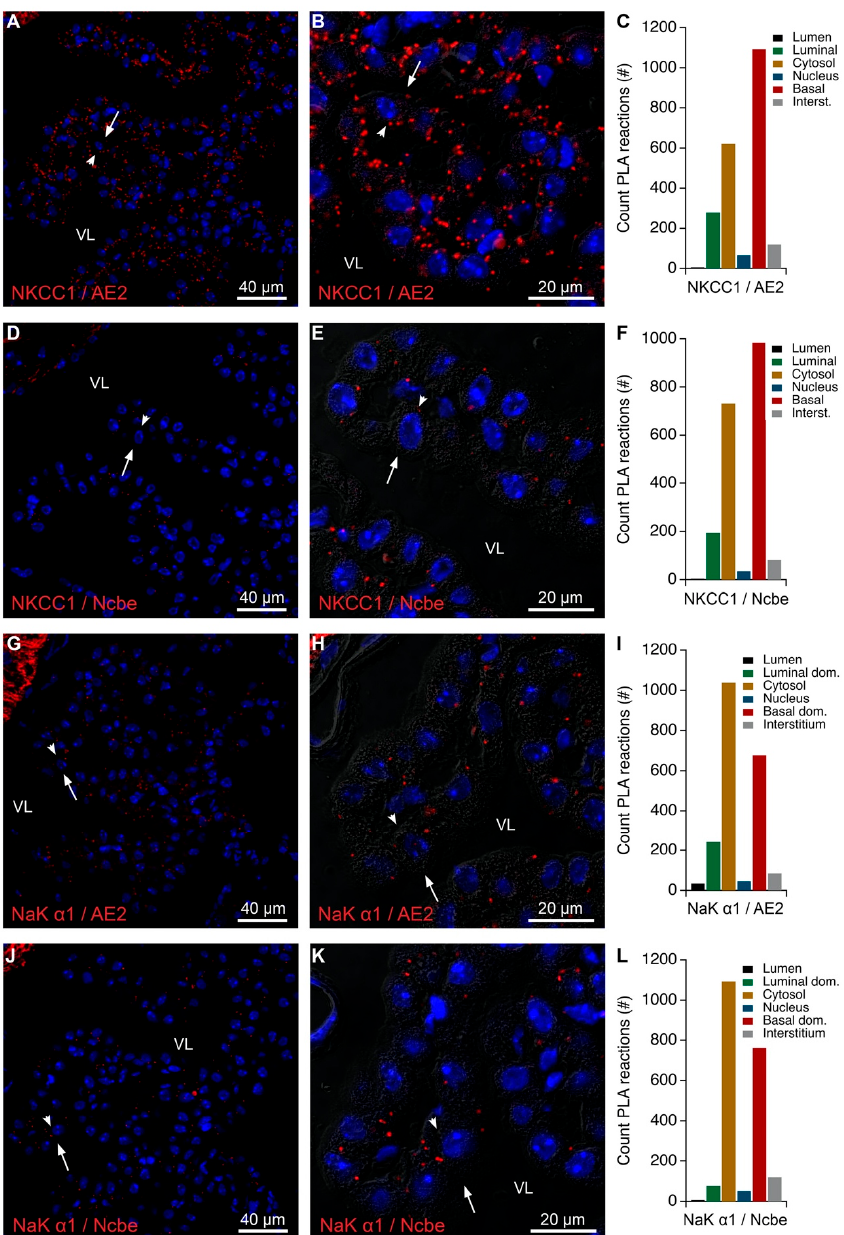
Figure 7. Colocalization of AE2 or Ncbe with NKCC1 or the Na,K-ATPase α 1 by PLA. ( A ) Representative immunofluo- rescence image of PLA products (red) using anti-NKCC1 and anti-AE2 antibodies and cell nucleus counterstain (blue) at low magnification. ( B ) Higher magnification micrograph of the same structure overlaid on the corresponding DIC image. ( C ) Bar graph representing the count of PLA reactions in the indicated image areas. ( D ) Representative immunofluorescence image of PLA products (red) using anti-NKCC1 and anti-Ncbe antibodies and cell nucleus counterstain (blue) at low magnification. ( E ) Higher magnification micrograph of the same structure overlaid on the corresponding DIC image. ( F ) Bar graph representing the count of PLA reactions in the indicated image areas. ( G ) Representative immunofluorescence image of PLA products (red) using anti-Na,K-ATPase α 1 (NaK α 1) and anti-AE2 antibodies and cell nucleus counterstain (blue) at low magnification. ( H ) Higher magnification micrograph of the same structure overlaid on the corresponding DIC image. ( I ) Bar graph representing the count of PLA reactions in the indicated image areas. ( J ) Representative immunofluorescence image of PLA products (red) using anti-Na,K-ATPase α 1 (NaK α 1) and anti-Ncbe antibodies and cell nucleus counterstain (blue) at low magnification. ( K ) Higher magnification micrograph of the same structure overlaid on the corresponding DIC image. ( L ) Bar graph representing the count of PLA reactions in the indicated image areas. Arrows indicate luminal surfaces, while arrowheads mark basolateral surfaces. VL denotes the fourth ventricle